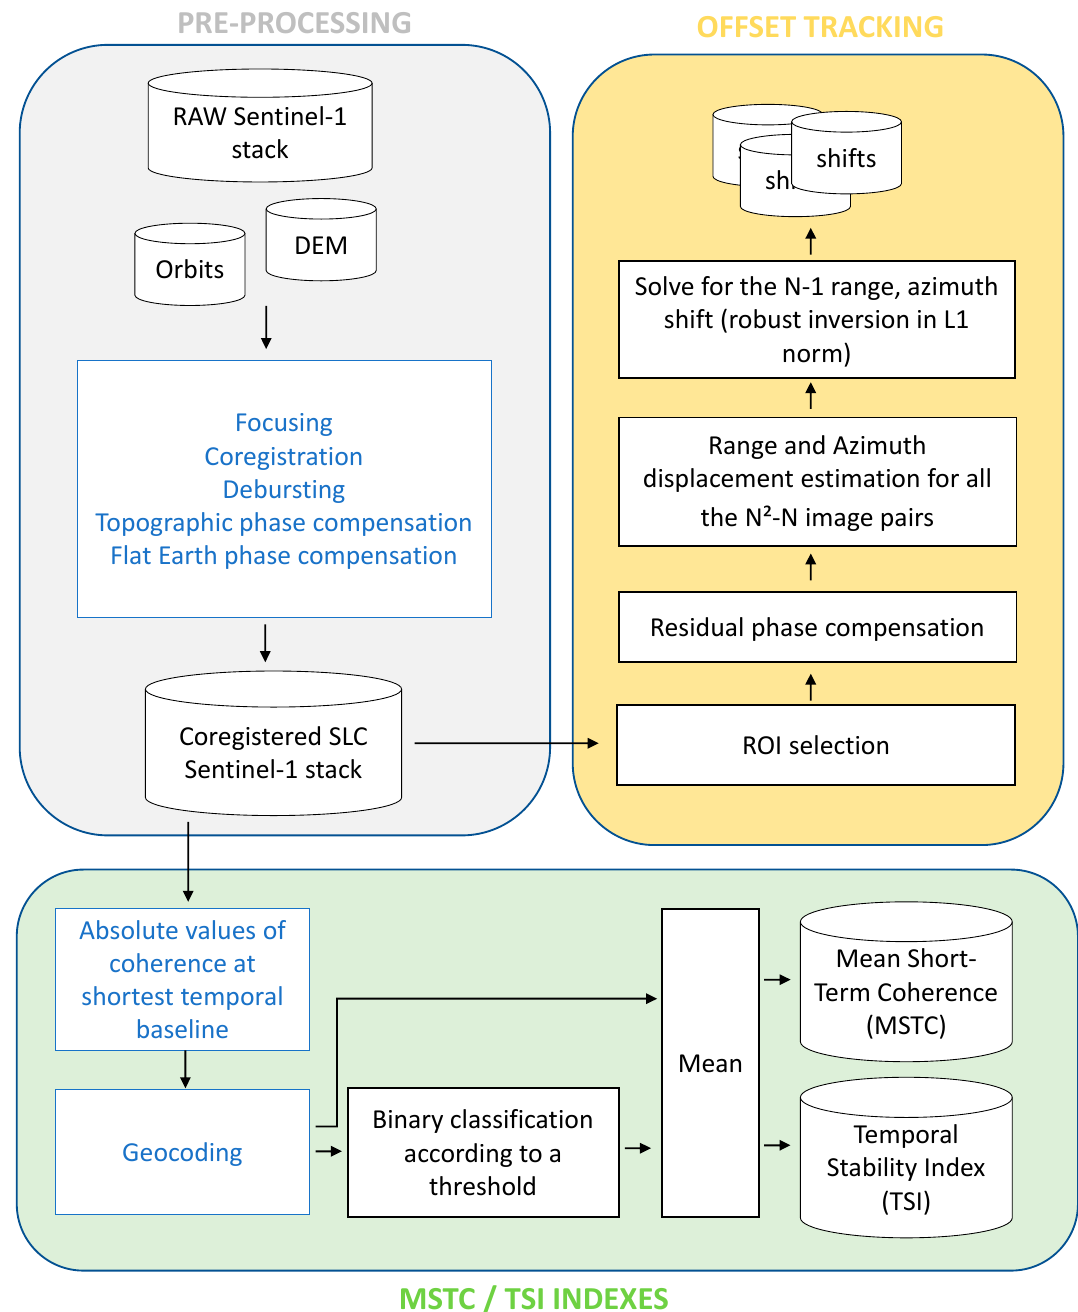
Figure 2. Diagram representing the steps performed for computation of coherence-based indexes (Mean Short-Term Coherence abbreviated as MSTC and Temporal Stability Index, abbreviated as TSI) and offsets estimations from SAR images stacks. Blue boxes specify the tools available in the SNAP (Sentinel Application Platform) software.